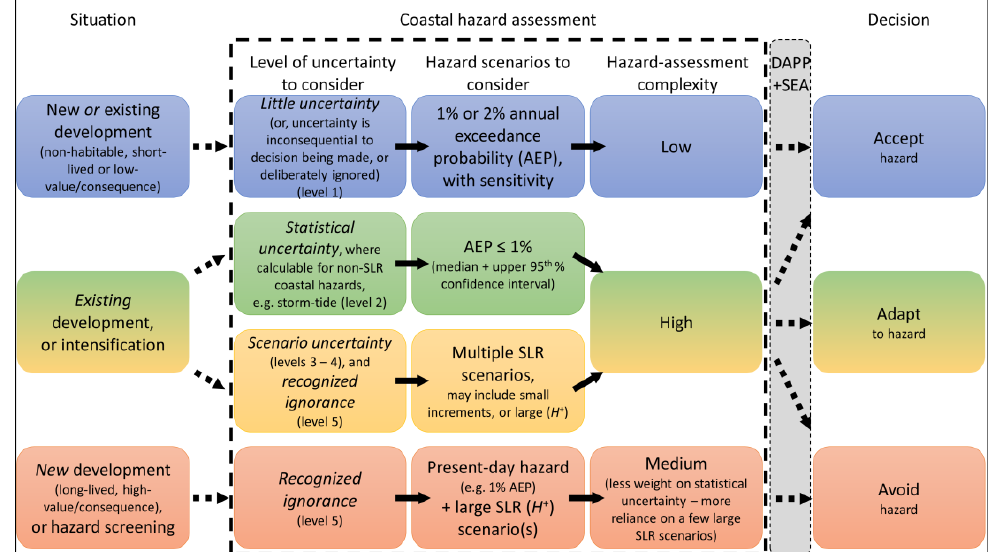
Figure 2. Uncertainty framework for coastal hazard assessments to support the DAPP process, showing a logical flow from the situation, to the related level of uncertainty as determined by the situation, the hazard scenarios to model, the likely hazard modeling complexity, and the possible decision type. A distinction is drawn (represented by the dashed arrows and dashed box) between the situation, the coastal hazard assessment process, the DAPP process and socio-economic assessment (SEA), and the decision type.